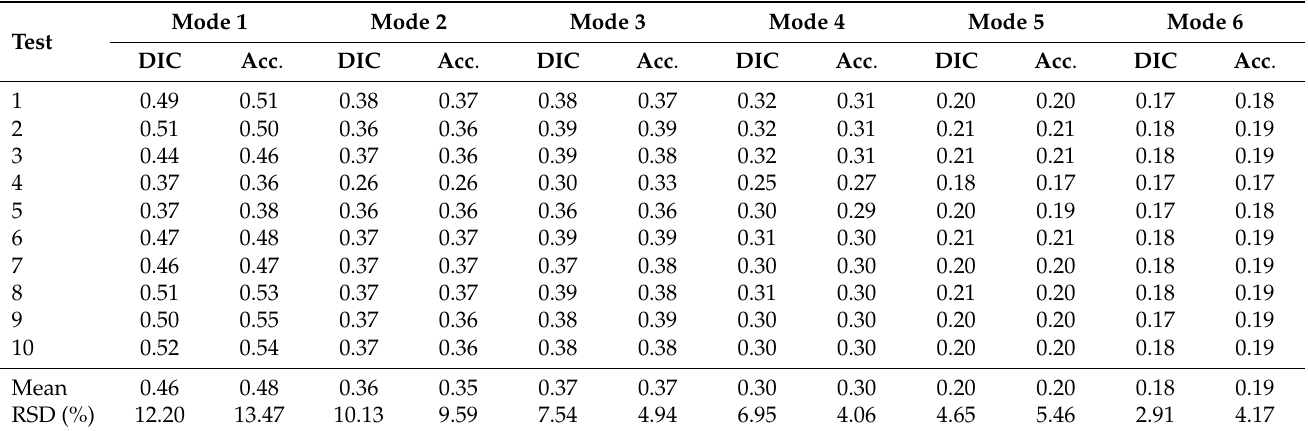
Table 3. Average modal damping ratios (in %) determined from DIC measurements and accelerome- ters for the clamped–clamped beam.